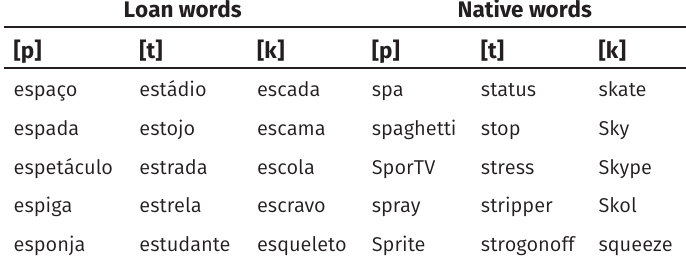
Table 1: Stimuli for native and loan